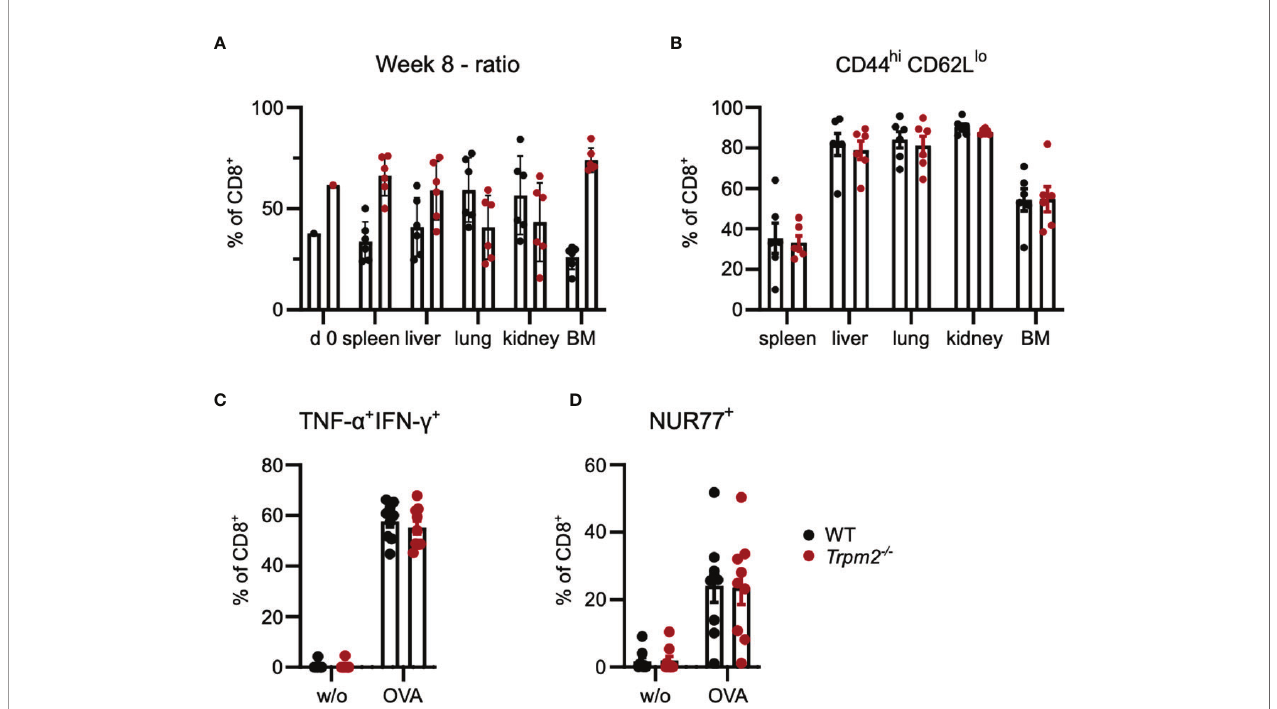
FIGURE 5 | TRPM2 de fi ciency does not impair the long-term CD8 + T-cell response to L. monocytogenes in a T-cell transfer model. 5,000 Trpm2 -/- CD8 + OT-1 T cells (CD90.1 - CD90.2 + ) and 5,000 WT CD8 + OT-1 T cells (CD90.1 + CD90.2 + ) were mixed and i.v. transferred to Rag1 -/- mice. Recipients were infected on the same day with LmOVA and analyzed 8 weeks later. (A) Frequencies of WT and Trpm2 -/- cells among CD8 + donor T cells at day 0 (mix before transfer) and 8 weeks postinfection in spleen, liver, lung, kidney, and bone marrow (BM). (B) Frequencies of CD44 hi CD62L lo donor CD8 + T cells in different tissues. (C) Spleen cells were stimulated for 4 h with OVA 257-264 peptide, and the frequencies of IFN- g + TNF- a + donor and recipient CD8 + T cells were determined by intracellular cytokine staining. (D) Frequencies of NUR77 + donor and recipient CD8 + T cells after OVA 257-264 peptide stimulation of spleen cells. Bars in give the mean ± SEM. Results in (B – D) and were analyzed with the unpaired t-test. One representative experiment of three is shown.